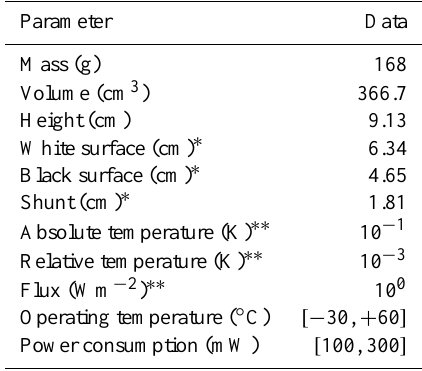
Table 3. Instrument data sheet: ∗ diameter; ∗∗